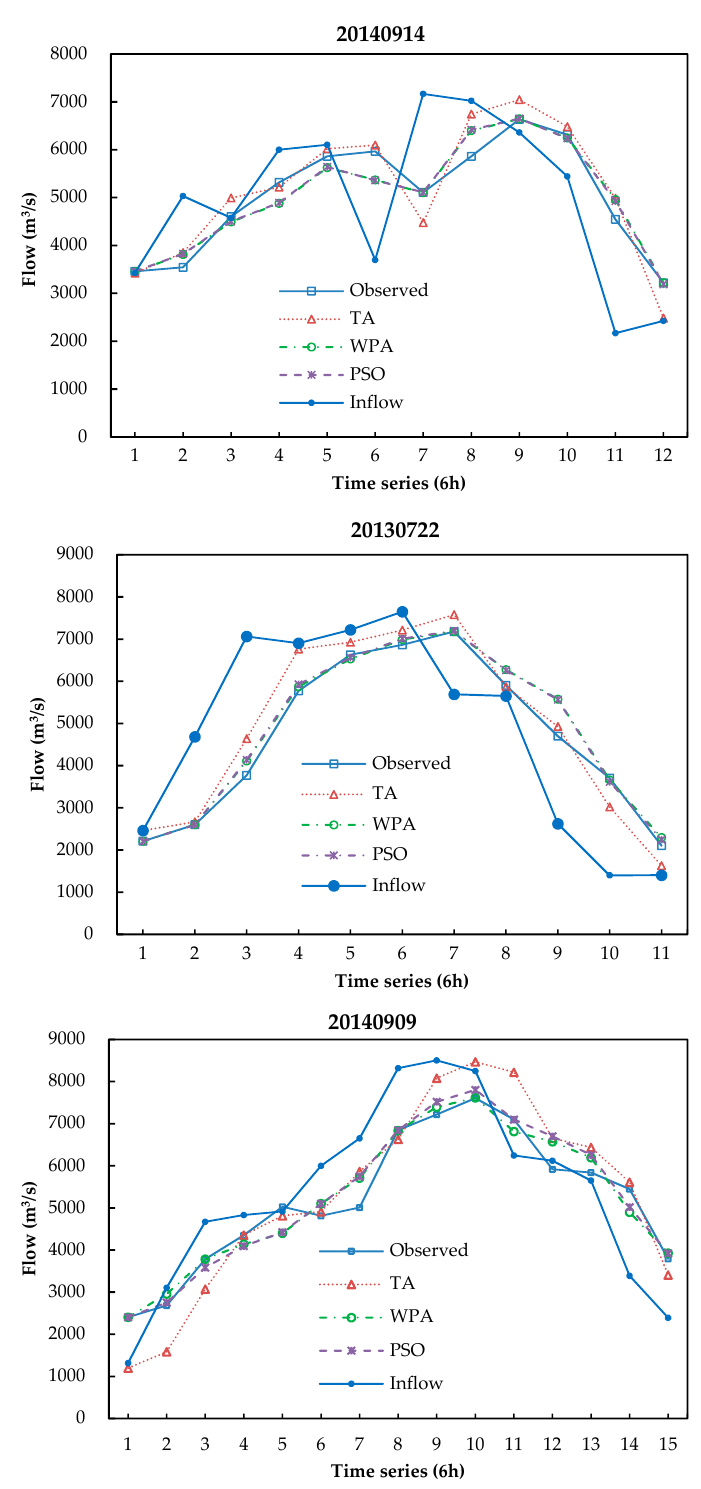
Figure 4. Simulation results of different floods in Reach 2.